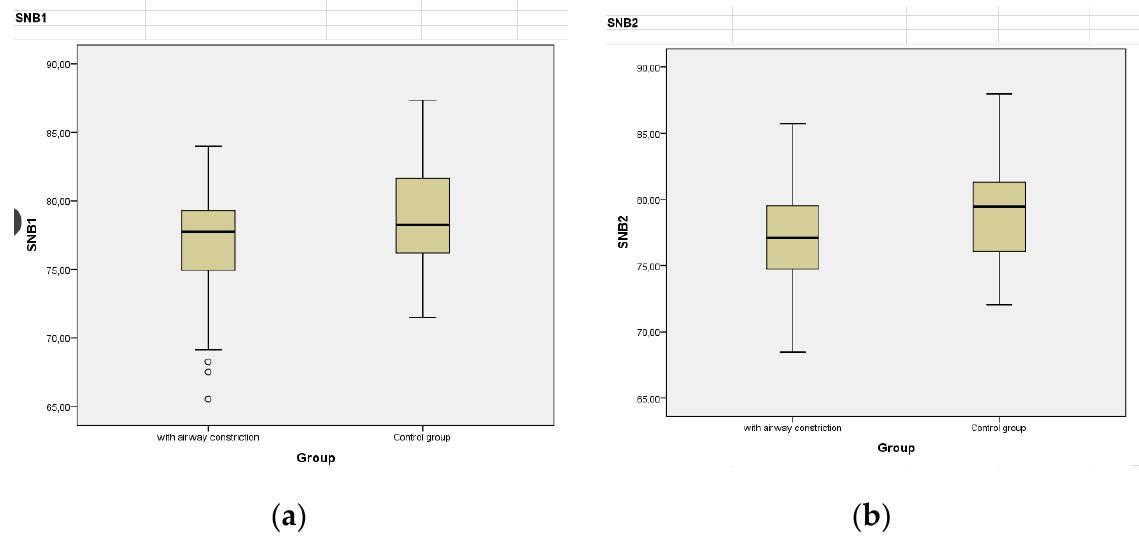
Figure 11. Values of SNB angle in groups A and B. The angle SNB formed by the points (1) Sella Turcica, (2) hard tissue Nasion (3) point B. ( a ) Pre-treatment SNB angle in group A ( left ) and group B ( right ); ( b ) Post-treatment SNB angle in group A ( left ) and group B ( right ). Another parameter that was taken into consideration was ANB, an angle formed by the skeletal points A and B and the point Nasion, but no statistical difference was found. A dental parameter that was also examined was U1SN, representing the inclination of the upper central incisors to the SN (Sella-Nasion) line with a mean value of 99.40 before and 97.81 after treatment in group A, and 105.74 and 100.12 in control group B, respectively. A comparison of the values of the lower central incisors’ inclination in reference to the cephalographic lines NB is presented in Table 2 for both groups. Table 2. Inclination of the lower central incisors, test of normality.